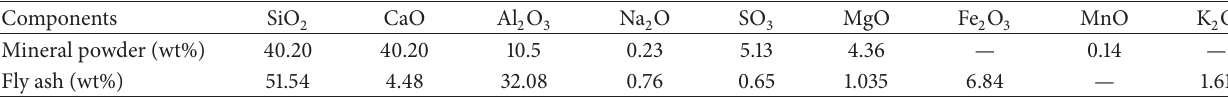
Table 2: Chemical compositions of mineral powder and fly ash.